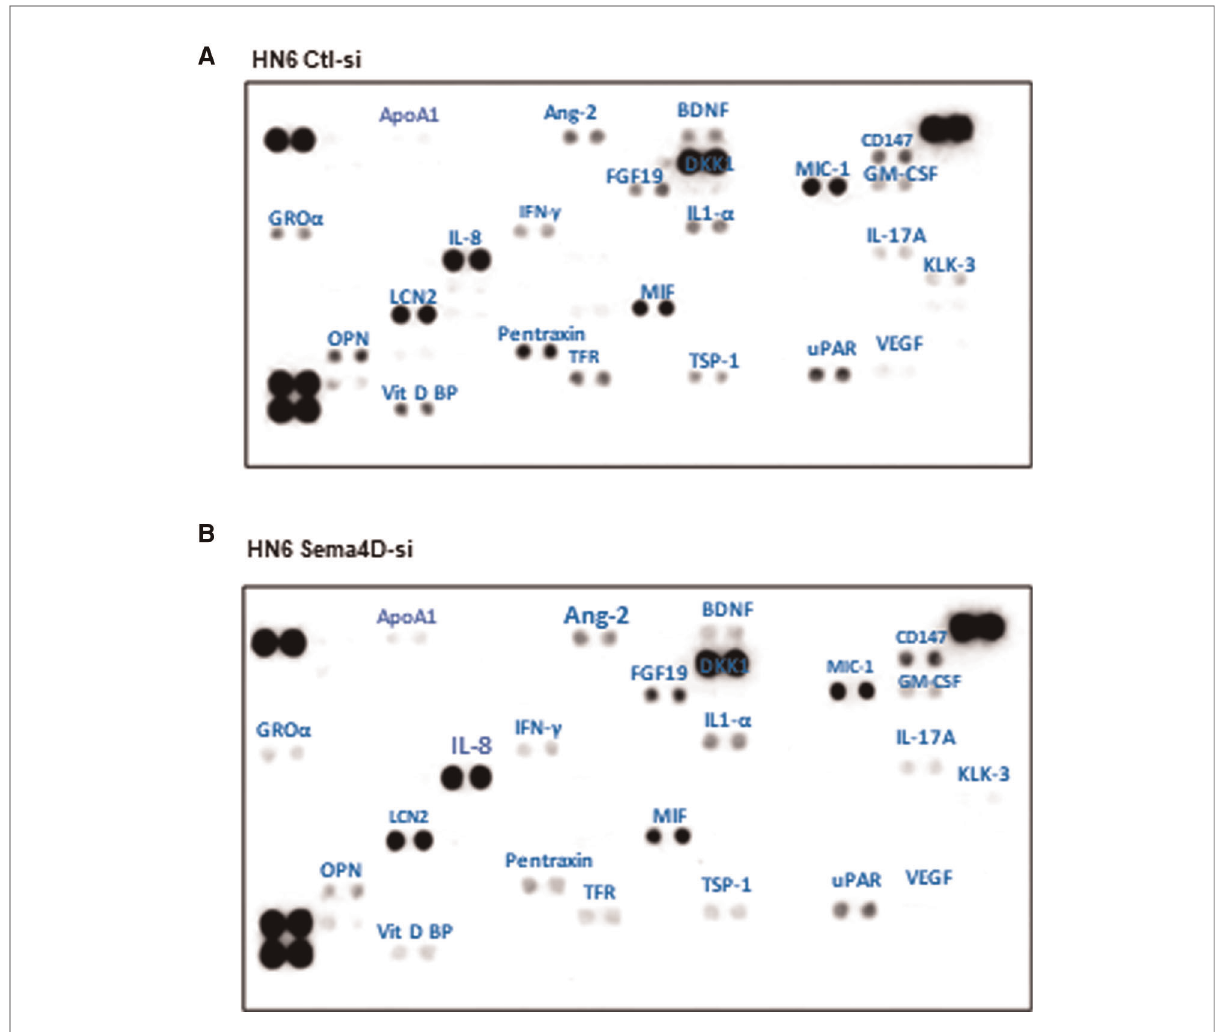
FIGURE 4 In vitro cytokine expression in HNSCC HN6 cell line upon Sema4D inhibition. ( A ) CM of HNSCC HN6 cell line after 3 days of control SiRNA transfection versus, ( B ) Sema4D siRNA transfection. CM, conditioned